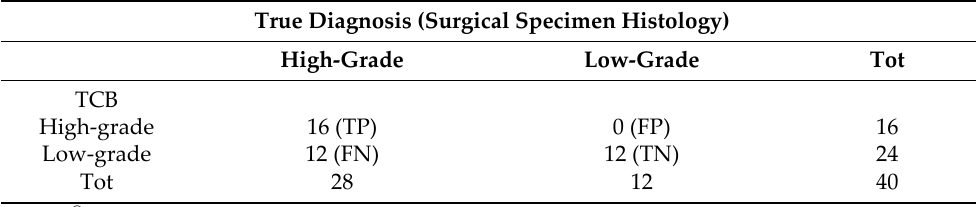
Table 6. Accuracy of Tru‑Cut ® Biopsy Techniques Determining Malignancy When Compared to The Final Diagnosis. Analysis of 40 MLS Not Treated with Neoadjuvant